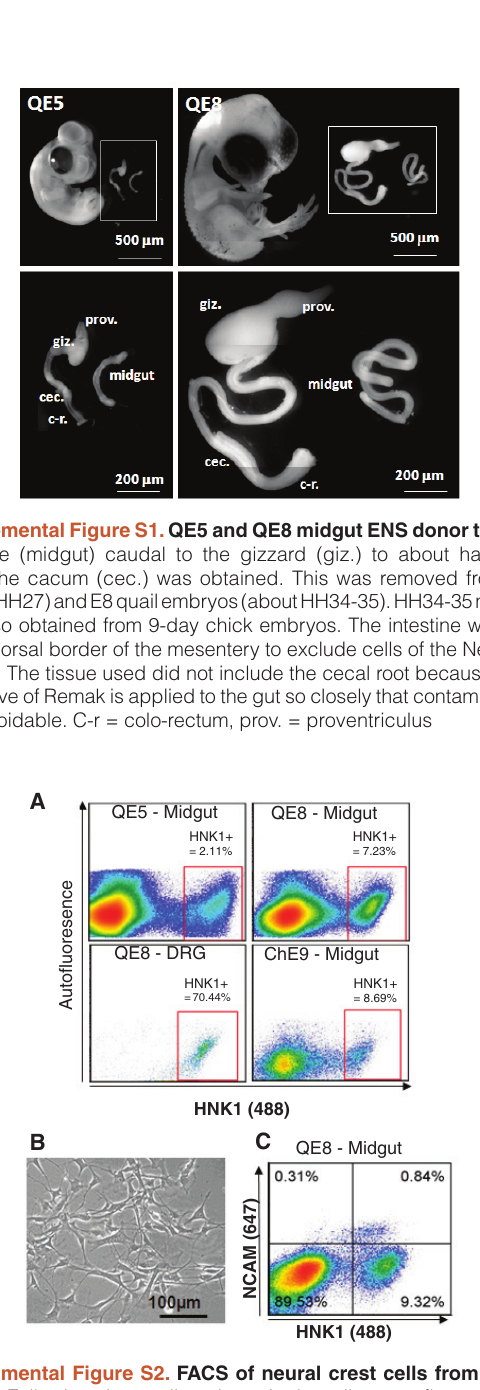
Supplemental Figure S2. FACS of neural crest cells from avian tissue. Following tissue digestion, single cells were fluorescently labelled with HNK1 and HNK1/NCAM and cells sorted by FACS. ( A ) Scatter plots show typical results of sorting embryonic tissue from quail embryonic day 5 (QE5), QE8, and chicken embryonic day 9 (ChE9). The typical percentage yields of HNK1 +ve cells are shown following FACS of single cells from the midgut and dorsal root ganglia (DRG). ( B ) QE5 MG HNK1 +ve cells plated on laminin show the characteristic multipolar morphology of ENC cells. ( C ) QE8 midguts were digested and single cells fluorescently labelled with HNK1 (Alexa 488) and NCAM (Alexa 647). The scatter plot shows that the majority of NCAM +ve cells also express HNK1. NCAM +ve /HNK1 +ve are able to be differentially sorted from the NCAM -ve /HNK1 +ve population.